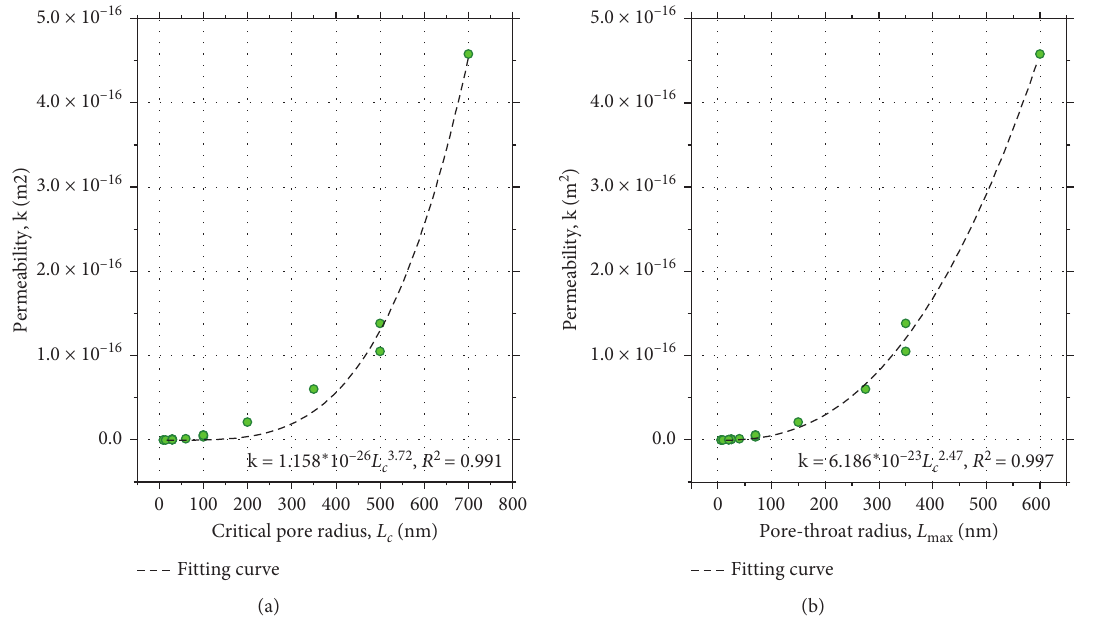
Figure 12: Correlation between characteristic pore radius and